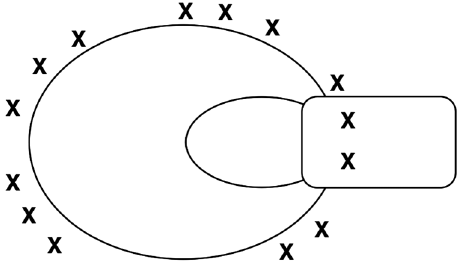
FIG. 1. Initial layout of ropes (lines) and people (Xs) for enactment of Energy Theater for an incandescent